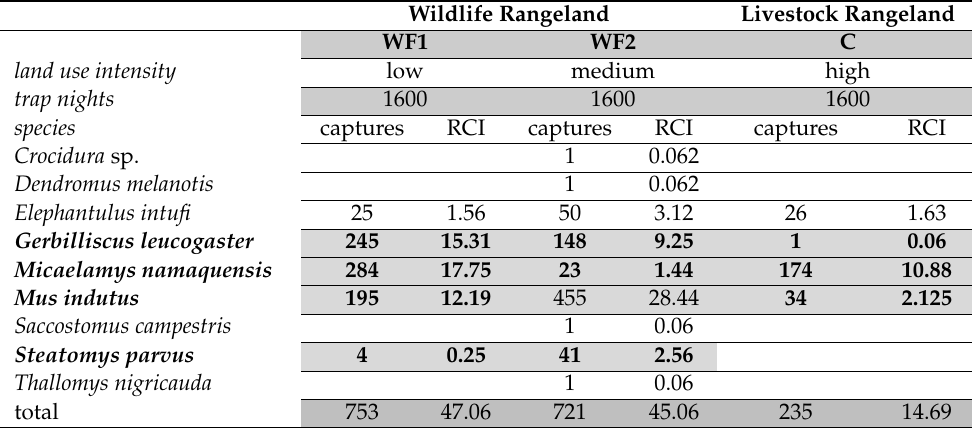
Table 1. Summary of trapping data (total number of captures per species across all trapping sessions) from study sites on private farmland at the southern Etosha boundary; changes in species’ capture frequency of ≥ 50% between classes of land use intensity are highlighted in bold. RCI—relative capture index based on number of captures per 100 trap nights. WF1 / WF2—near-natural wildlife rangeland / wildlife rangeland close to artificial waterhole, C—cattle farm. Wildlife Rangeland Livestock Rangeland